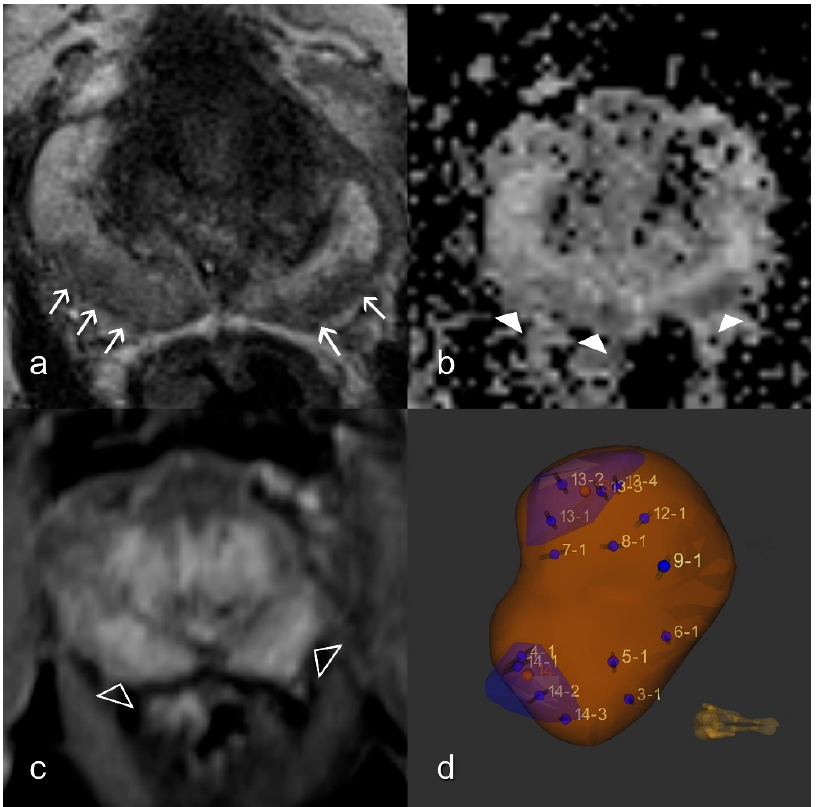
Figure 2. Reference standard. Imaging findings showing patchy T2W signal attenuation (white arrows) in the peripheral zone on both sides ( a ), moderate reduction (white arrowheads) in the ADC map ( b ), and diffuse enhancement (empty arrowheads) in the dynamic T1W VIBE ( c ); Formally, this represents the PI-RADS 3 constellation; ( d ) The MRI/ultrasound (US)-guided biopsy 3D model depicts the target lesions in the blue zones and the template biopsy cores (numbered). Pathology confirmed no malignancy. ADC, apparent diffusion coefficient; T1W, T1-weighted; T2W, T2-weighted; VIBE, Volumetric interpolated breath-hold examination.